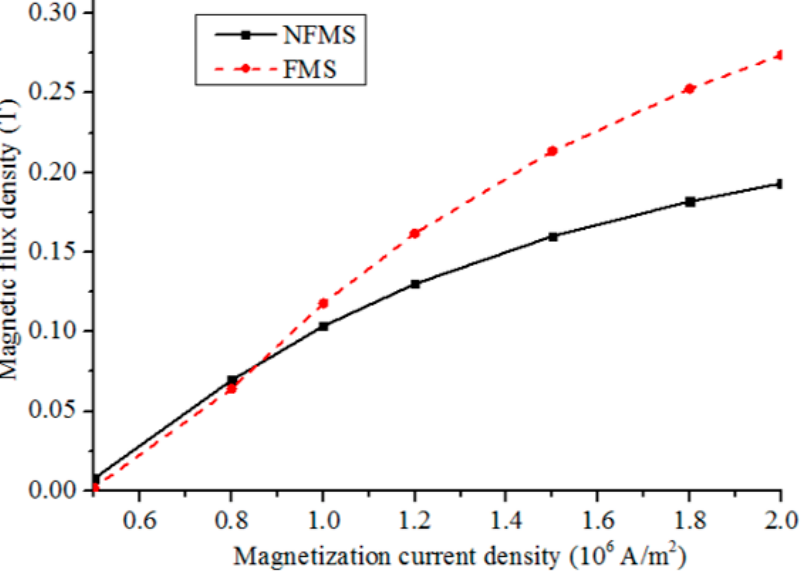
Figure 7. The MFL peak-to-peak amplitudes at different lift-off distances with different magnetization current densities.